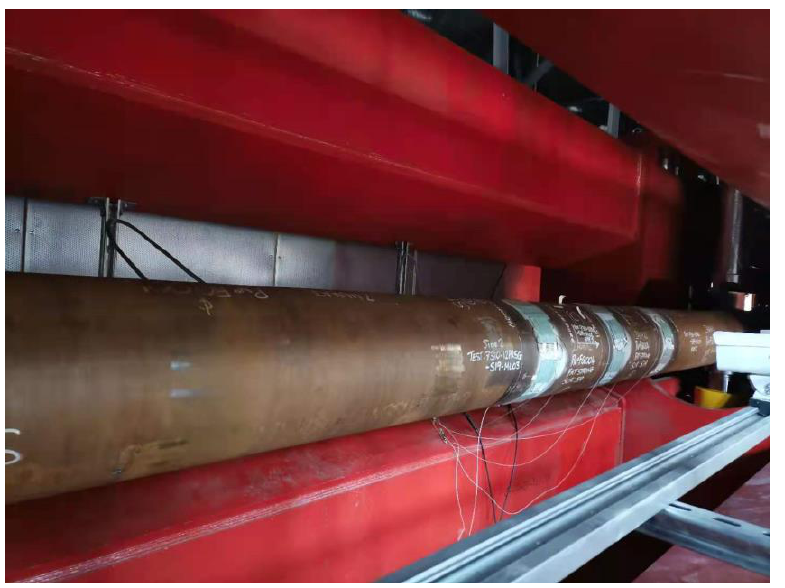
Figure 16. Full-size SCR test specimen.